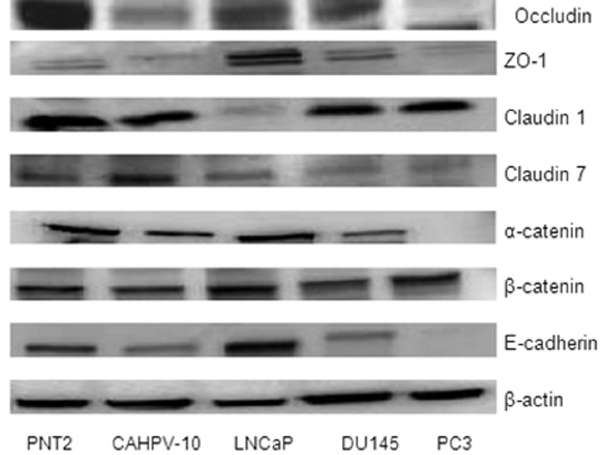
Figure 2. Western blot analysis demonstrating differential expression of Adherens and Tight junction protein expression in normal prostate cells (PNT2) and prostate cancer cell lines (CAHPV-10, LNCaP, DU145 and PC-3). b -actin was used as a loading control. Western blots were performed in duplicate and bands are representative of results